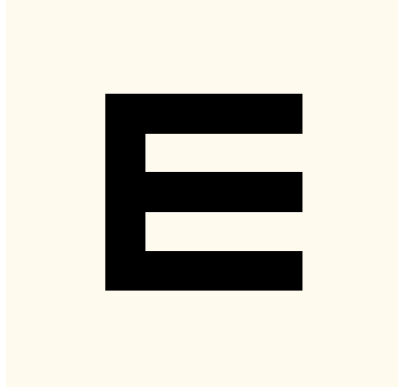
Figure 1. Letter optotype: Snellen E.